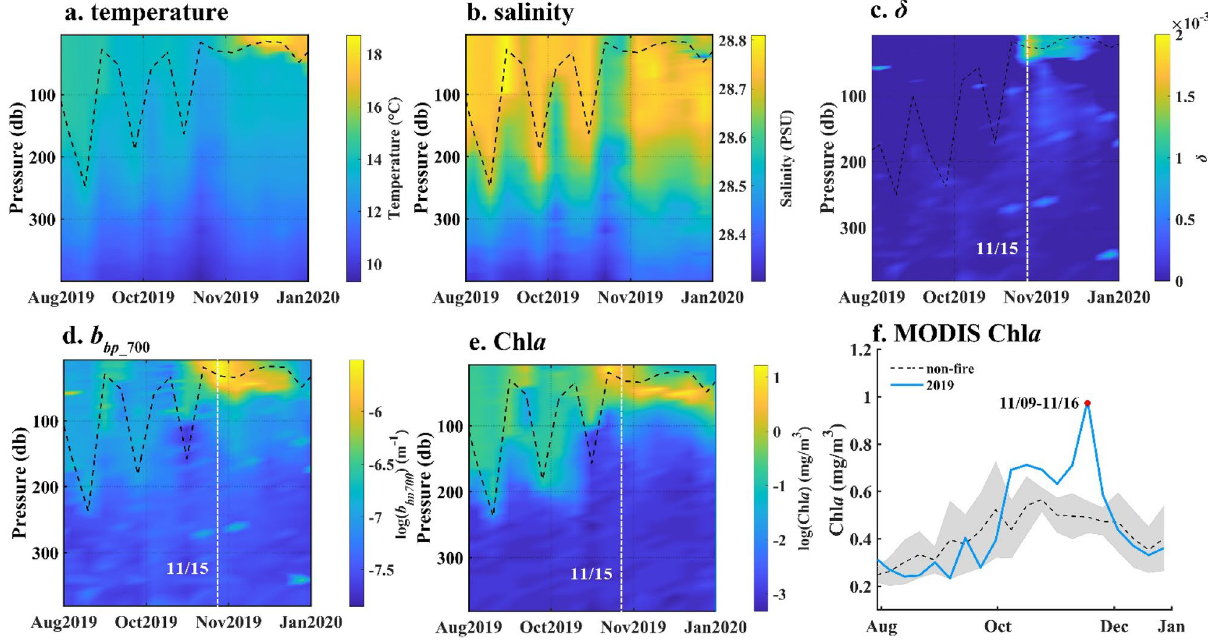
Figure 7. SOCCOM BGC-Argo float (No. 5905108) data and MODIS Aqua 8-day average Chl a in the same area. ( a ) temperature; ( b ) salinity; ( c ) δ ; ( d ) b bp_ 700 ; ( e ) Chl a ; ( f ) MODIS 8-day average Chl a . No. 5905108 float was located in the northeast sea of New Zealand, which is shown in Fig. 1b. The dashed black lines indicate the mixed layer depth (MLD). The white dashed lines indicate the date when surface Chl a reached its